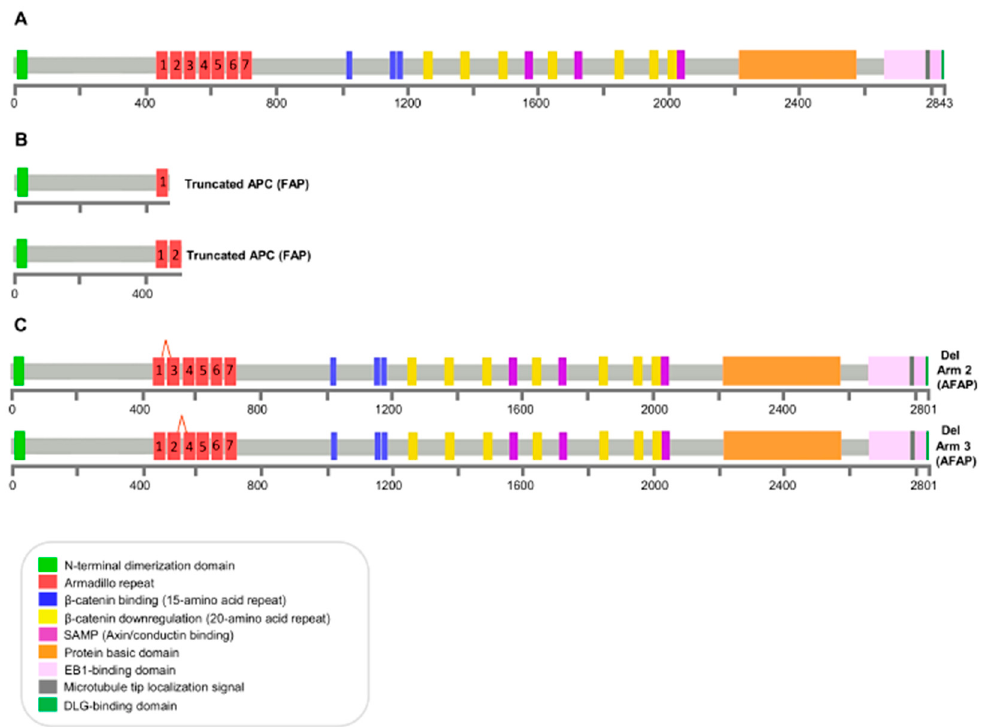
Figure 4. APC coding region. ( A ) Schematic diagram of wild type APC protein, depicting conserved regions and domains that interact with other proteins. ( B ) Schematic diagram of APC truncated proteins that result from total removal of ARM2 and/or ARM3 along with disruption of all downstream APC domains and are associated with the classic FAP phenotype. ( C ) Schematic diagram of APC variants that result from exon 12 or exon 13 splicing mutations leading to an in-frame protein and are associated with the AFAP phenotype.